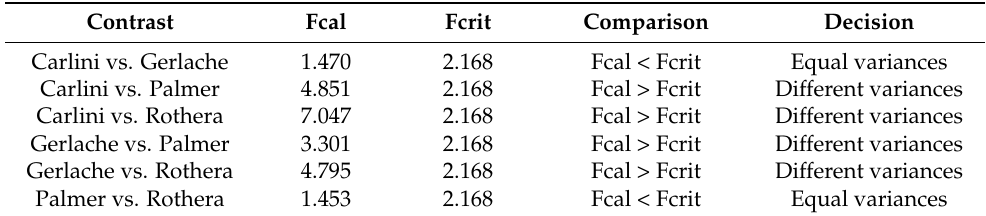
Table 3. Results of the multiple-contrast approximation based on the F-test. We used n = 20 for all series and an alpha error = 5% in each